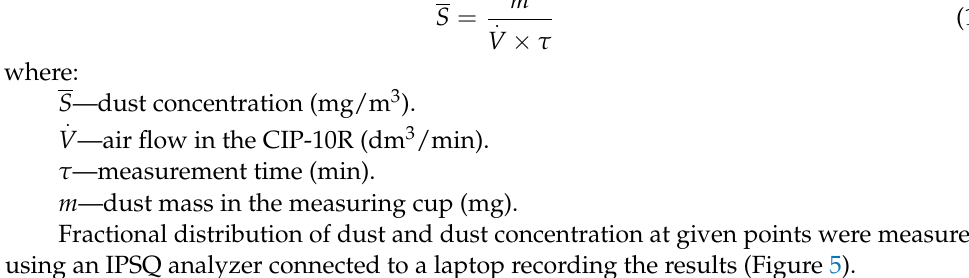
(b) Figure 5. IPSQ analyzer, consisting of: ( a ) electronic measuring block with a computer; ( b ) measur- ing probe.